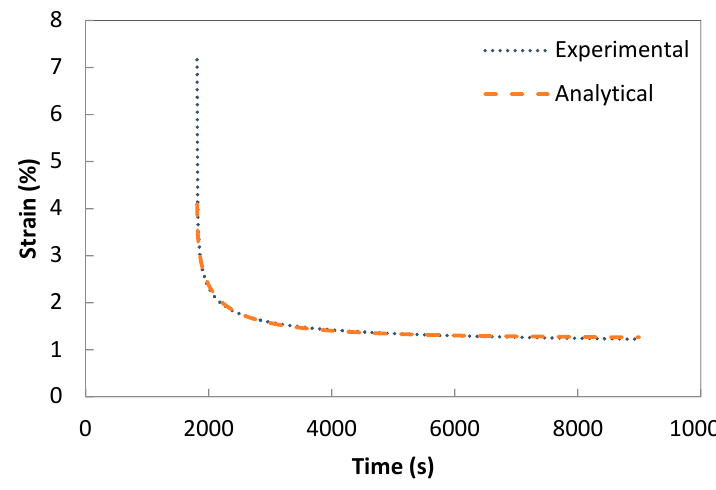
Figure 11. Modelling the recovery component of PB3 by a Weibull distribution function.